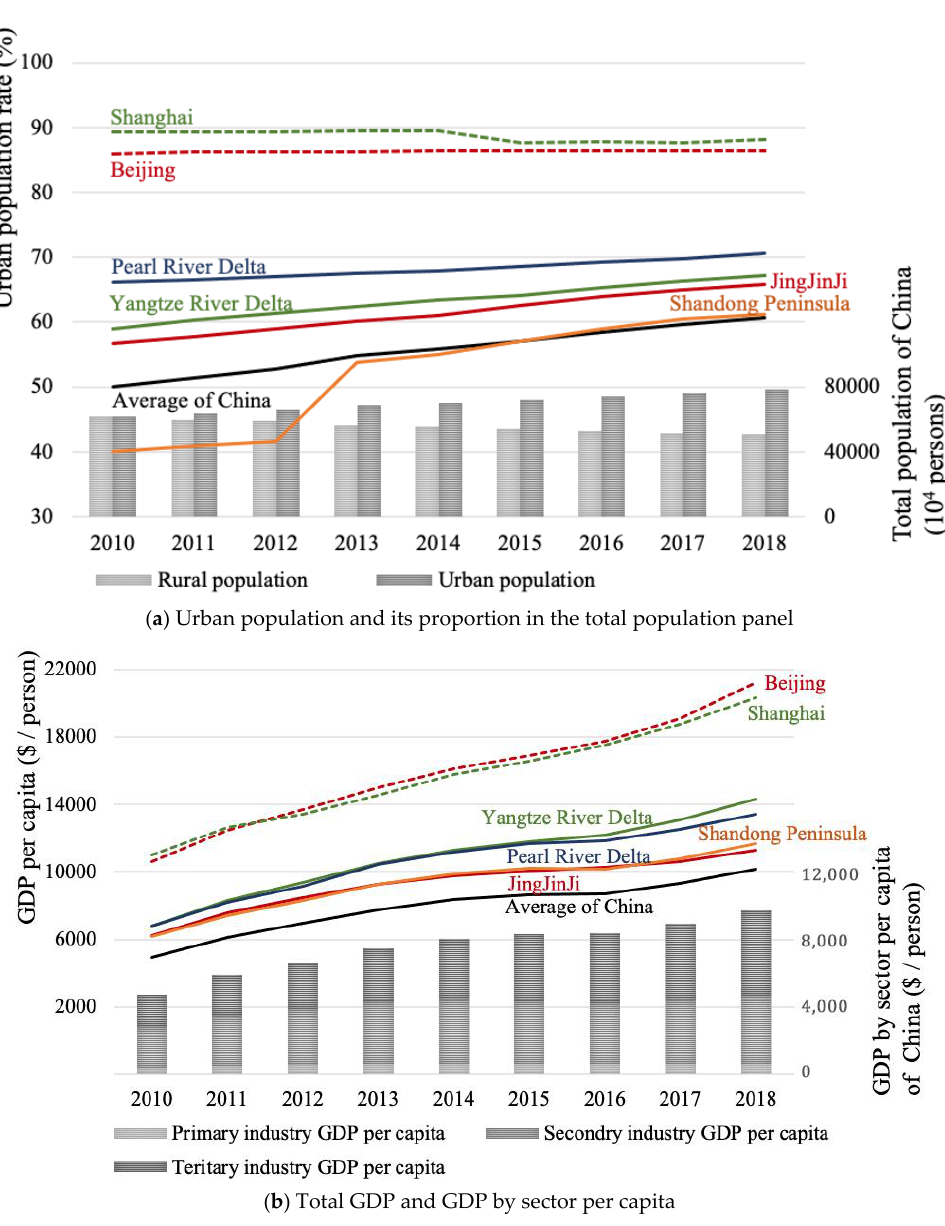
Figure 3. The trend of urbanization economies in China from 2010 to 2018. (Data source: China Statistical Yearbook 2011 – 2019 [36]).